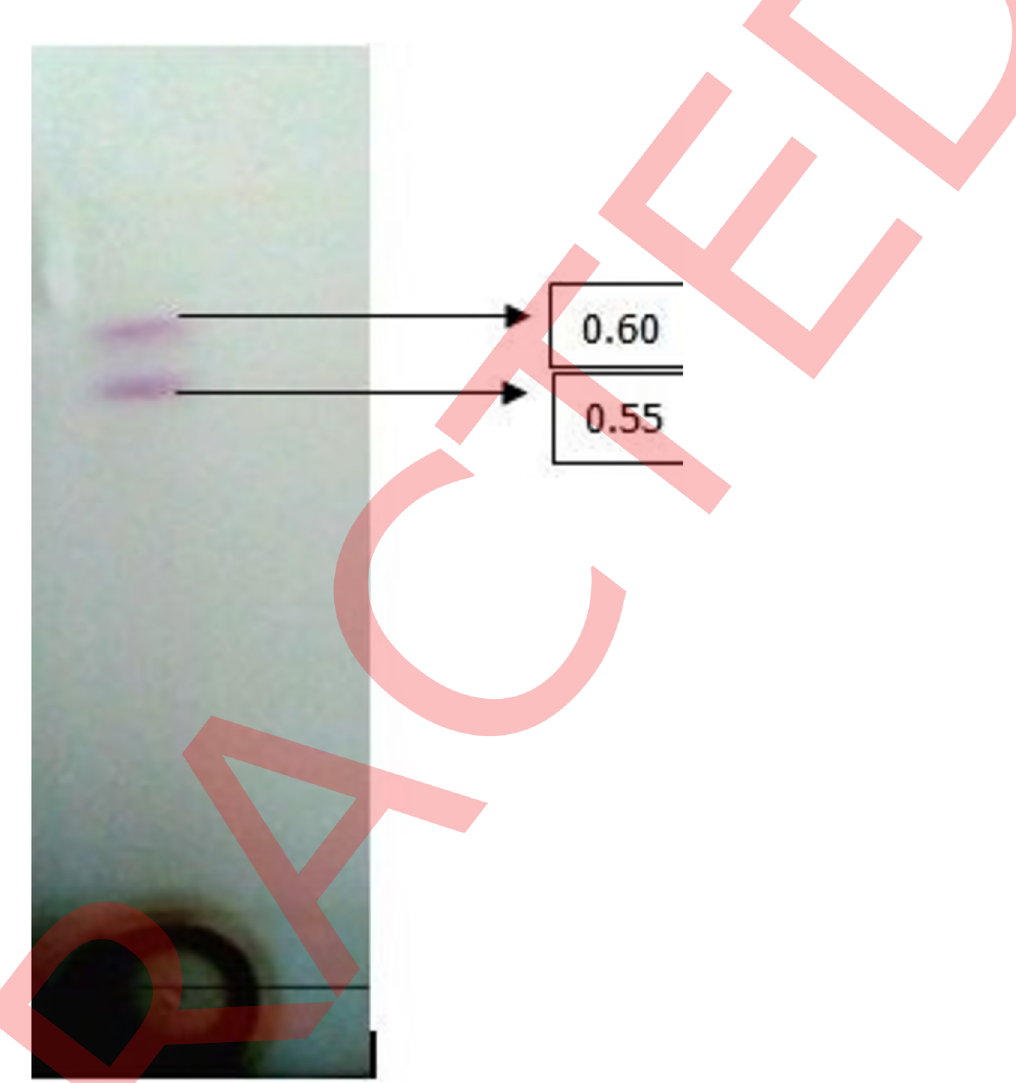
Fig 3. Thin-layer chromatography of glycolipid biosurfactant by S . puniceus RHPR9.